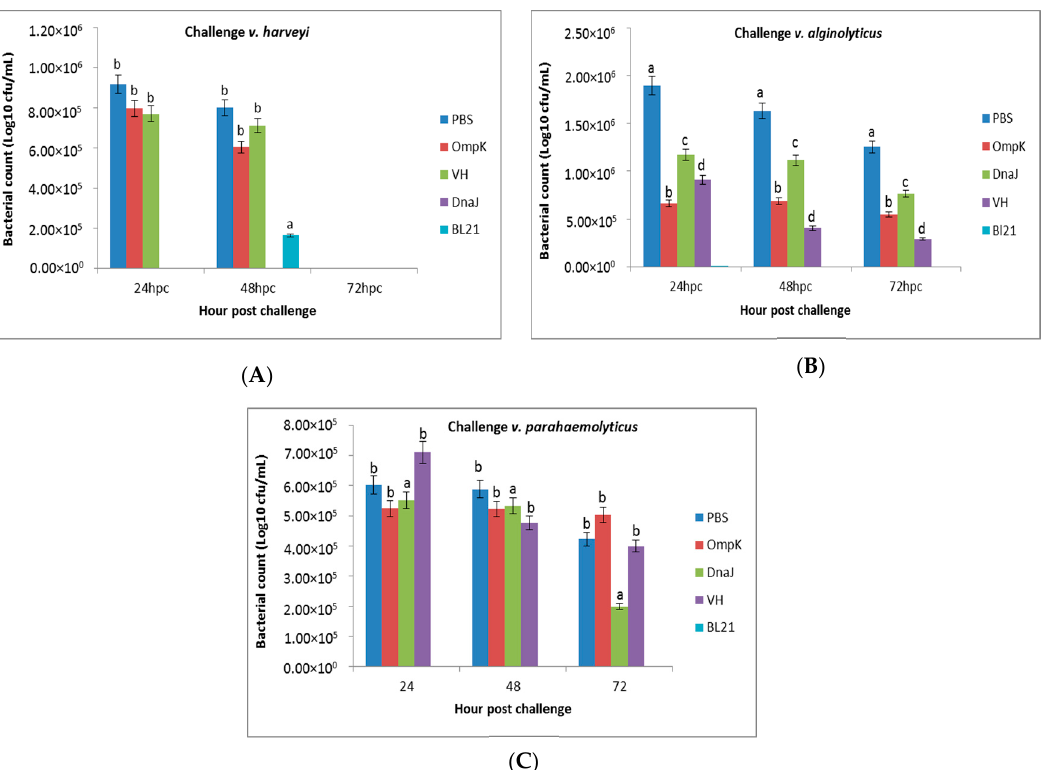
Figure 9. Bacterial count (cfu / mL) in serum of non-vaccinated and vaccinated juvenile seabass at 24, 48, and 72 h post-challenge with ( A ) V. harveyi , ( B ) V. parahaemolyticus , and ( C ) V. alginolyticus . Significant differences are indicated by different letters ( p < 0.05).